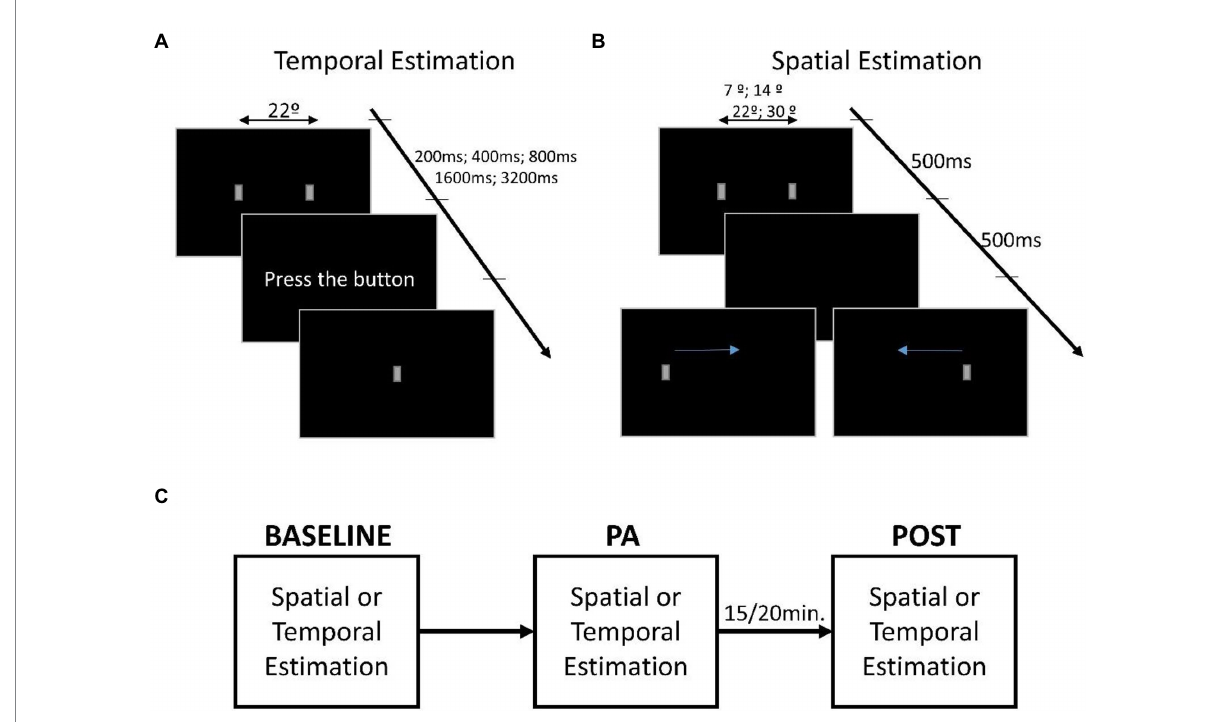
FIGURE 1 Representation of the estimation tasks. (A) Description of the time estimation task in which the first screen shows two small gray rectangles equidistant from the center of the screen. The presentation duration of stimuli can be 200, 400, 800, 1,600, and 3,200 ms, while the distance between rectangles is fixed. Once the stimuli have disappeared, the words “press the button” appear, only at which point the participant must press the space bar to reproduce the duration of the stimuli, making a small rectangle appear as visual feedback. (B) Description of the